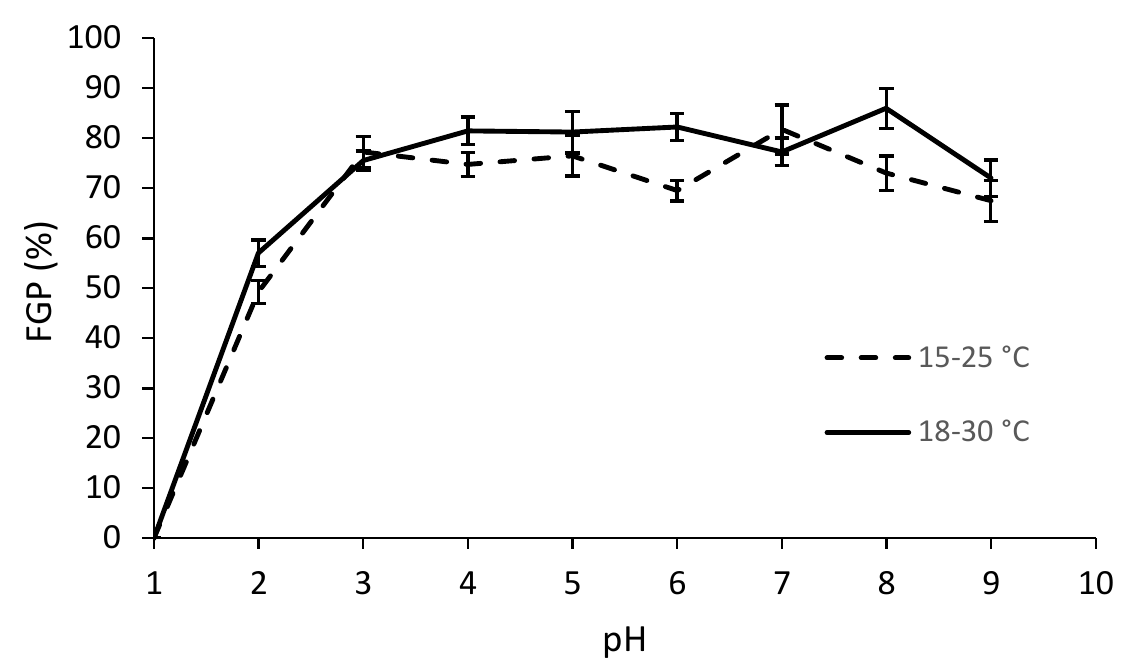
Figure 4 . Final germination percentages (FGP) of D. stramonium in different temperature ranges and pH levels (data from the two populations were averaged). Vertical bars represent the standard errors.